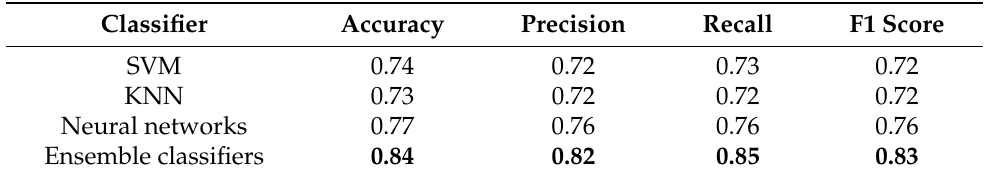
Table 3. Comparative evaluation metrics of state-of-the-art classifiers on the test dataset. Bold font indicates best result obtained for each